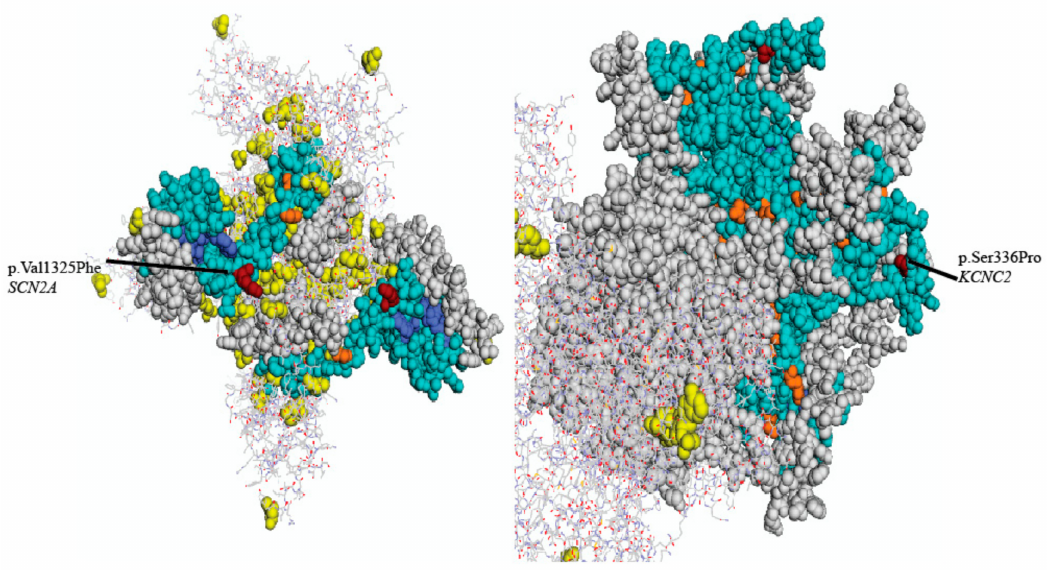
Figure 2. Three-dimensional structural homology model of the available structural modelling of sodium channel α 2-subunit Nav1.2 ( left ) and the voltage-gated potassium channel, Kv3.2 ( right ) with mapped EA-related mutations. Arrows represent two residues SCN2A (p. Val1325Phe, left ) and KCNC2 (p.Ser336Pro, right ) associated with EA-related